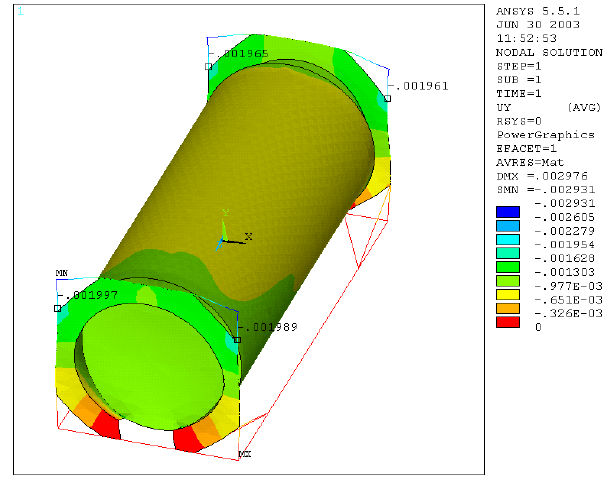
Figure 6. Displacements along y.